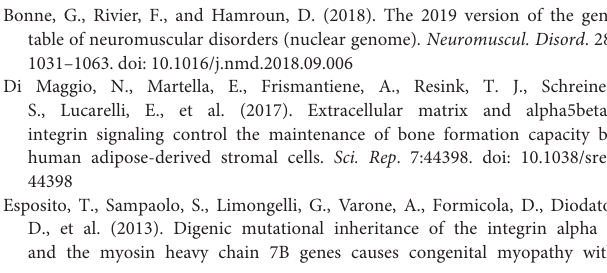
Supplementary Figure 1 | Schema of integrin alpha-7 with the mutation found in our patient. This homozygous mutation leads to a shift in the reading frame, resulting in truncating proteins with 15 miscoded amino acids.